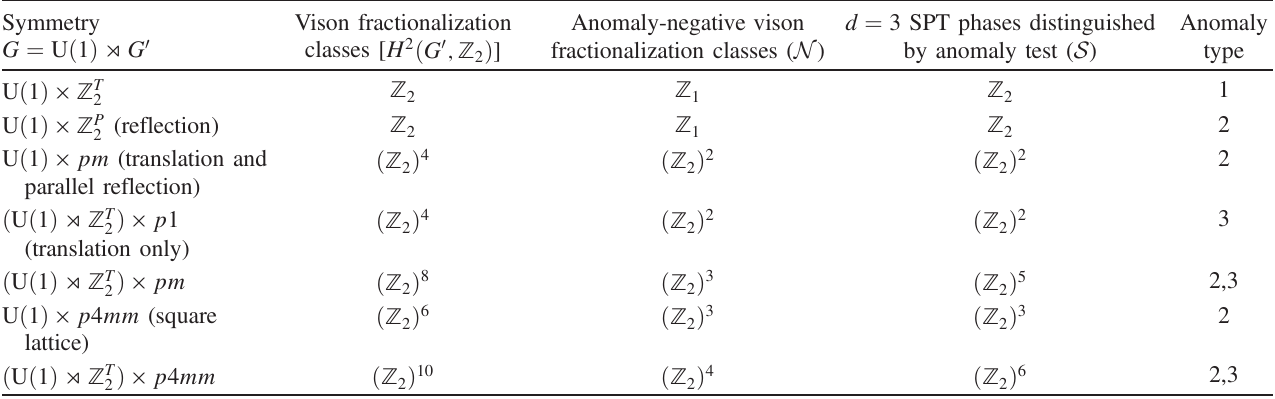
TABLE I. Summary of results. Each row is a distinct symmetry group, given in the first column. The last column indicates the type or types of anomalies that appear, as described in the text. The meaning of the other columns is discussed in the text. Z 1 denotes the trivial group. In all these cases, we consider Z 2 gauge theory whose gauge charge e carries half U(1) charge while the gauge flux m carries zero